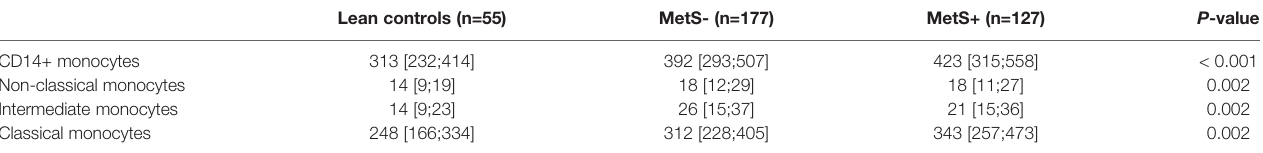
MetS-, morbidly obese patients without metabolic syndrome; MetS+, morbidly obese patients with metabolic syndrome. All absolute numbers are presented as median [interquartile range]. P-values are after correction for covariates using a binomial mixed regression